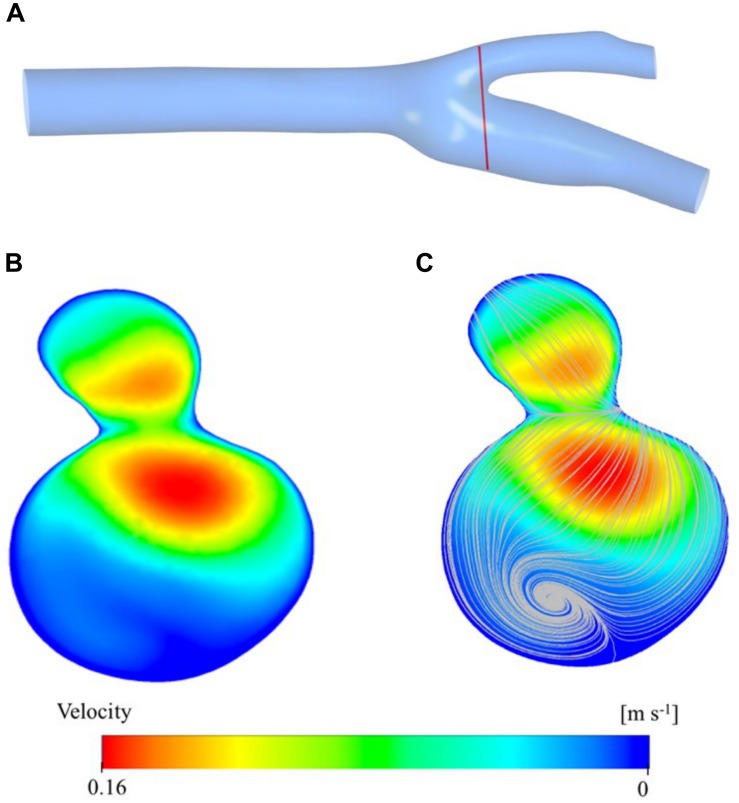
Velocity distribution at a cross section close to the bifurcation region is presented here: the location of the velocity magnitude contours (A), vorticity streamlines (B), and cross-sectional plane (C).